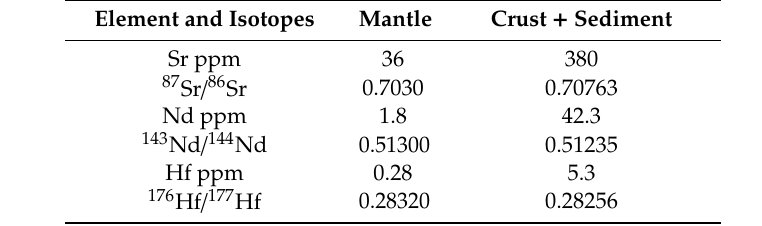
Table 5. Parameters used for the mantle modified by subducted crust + sediment model [22]. Element and Isotopes Mantle